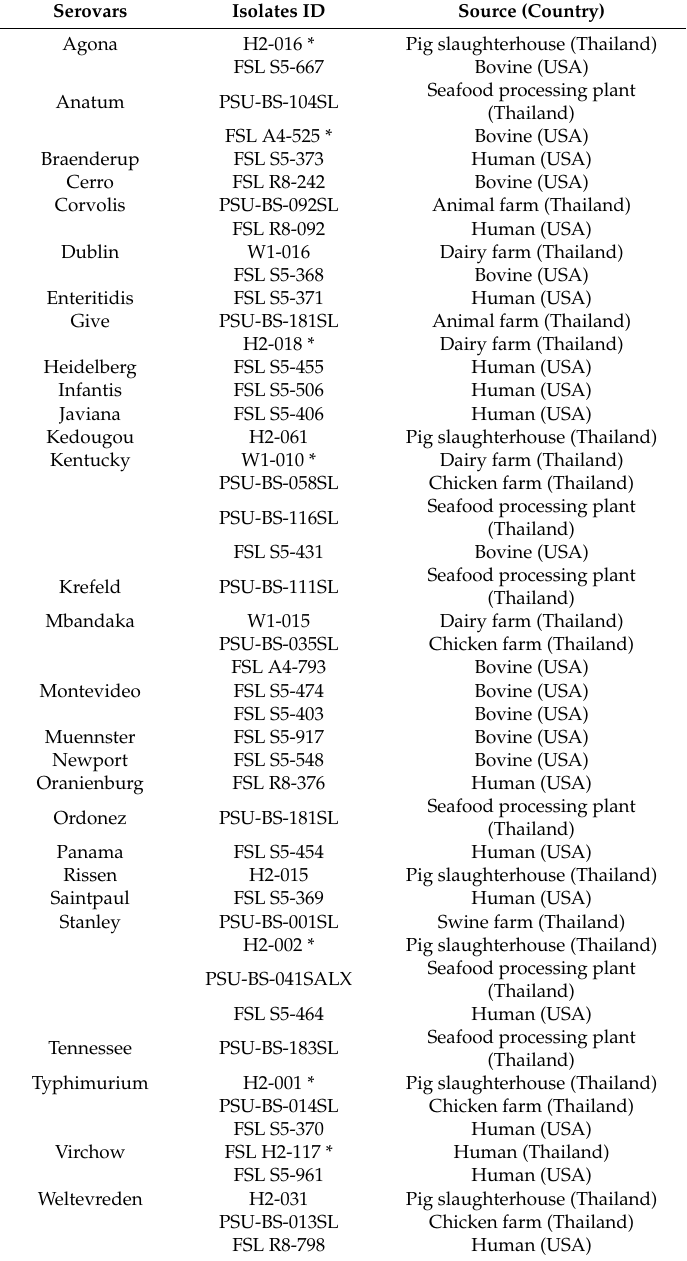
Table 1. Salmonella strains used for phage isolation and determination of phage lysis